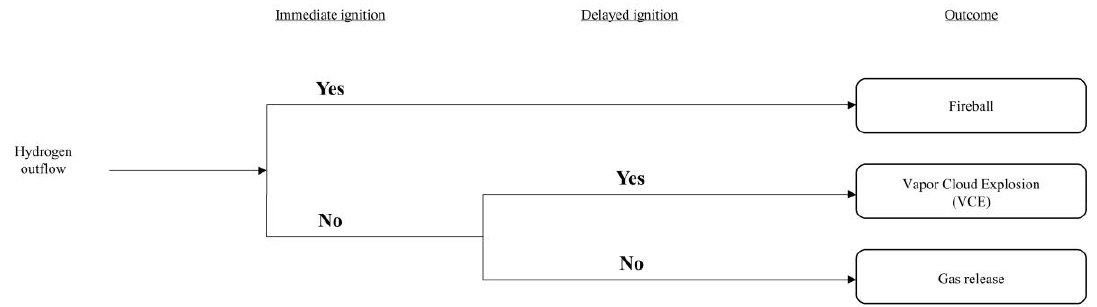
Figure 4. Event tree analysis (ETA) results.